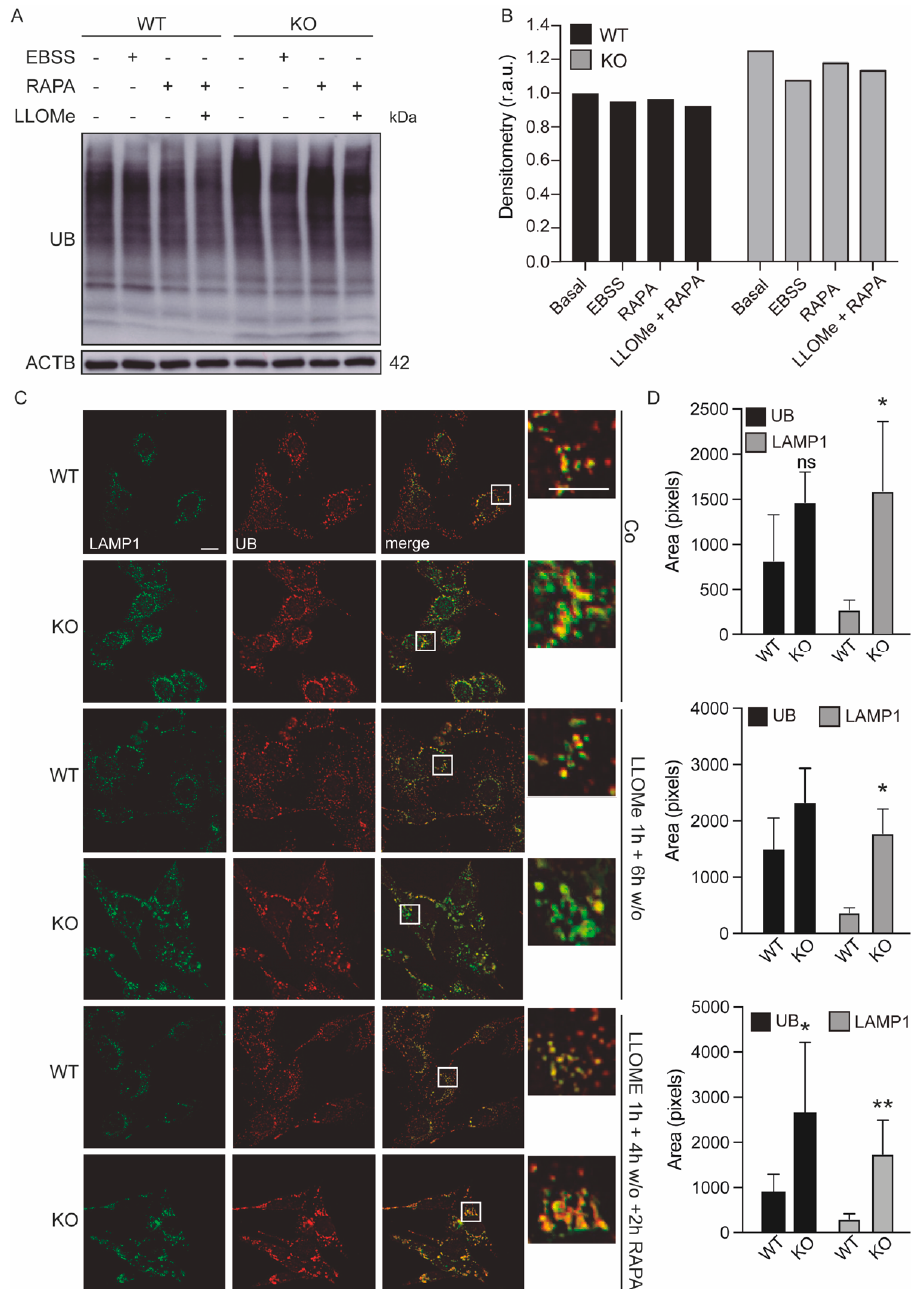
Figure 5. LAMP1–labeled structures of Keap1 KO cells are more sensitive to damage. ( A , B ) WT and Keap1 KO MEFs were cultured in control conditions, incubated with nutrient-free (EBSS) medium or treated with 1 µ M rapamycin (RAPA) alone or in combination with 1 mM LLOMe. Ubiquitin was assessed with immunoblotting. ACTB was used as a loading control. Densitometry was employed to quantify the abundance of ubiquitin normalized to ACTB. ( C , D ) WT and Keap1 KO MEFs were cultured in control conditions or incubated with 1 mM LLOMe for 1 h followed by a washout step, and 1 µ M rapamycin was added to one treatment in the last 2 h of washout. ( C ) Representative immunofluorescence images of cells costained with LAMP1 and UB antibodies. The scale bar represents 10 µ m. ( D ) The areas of ubiquitin-positive vesicles and LAMP1–positive vesicles were quantified and analyzed using two-way ANOVA following by Sidak’s multiple comparisons test. * p < 0.05, ** p < 0.01 vs. WT